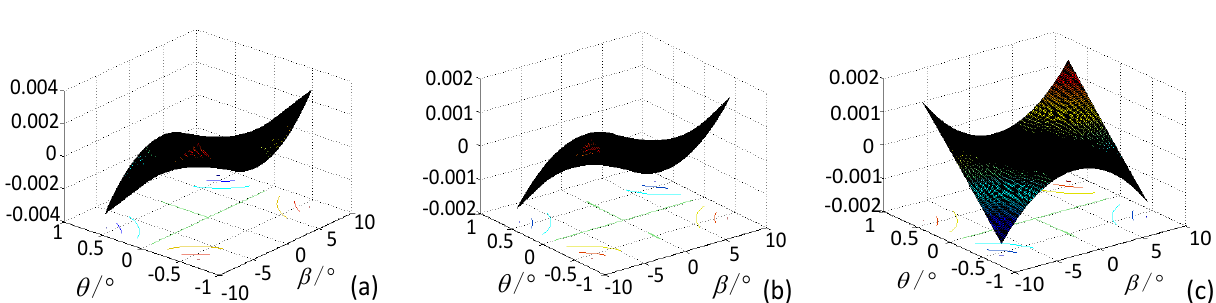
Figure 19. Relationship of the different distortion expressions. Z -axis of ( a ) represents (| P P | − | P P |)/pixel; Z -axis of ( b ) represents (| P Ti − Ri− Ti + Ri+ ( c ) represents (| P P | − | P P |)/pixel. Ti + Ri + Ii − Di −